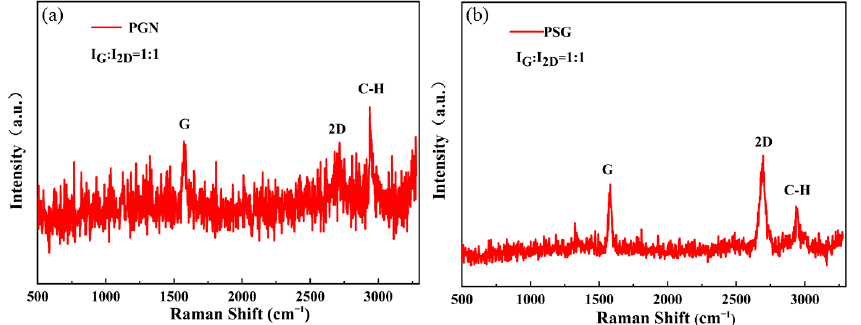
Figure 1. Raman spectra of ( a ) PSG and ( b ) PGN nanocomposites with the same M PLLA /M Graphene .